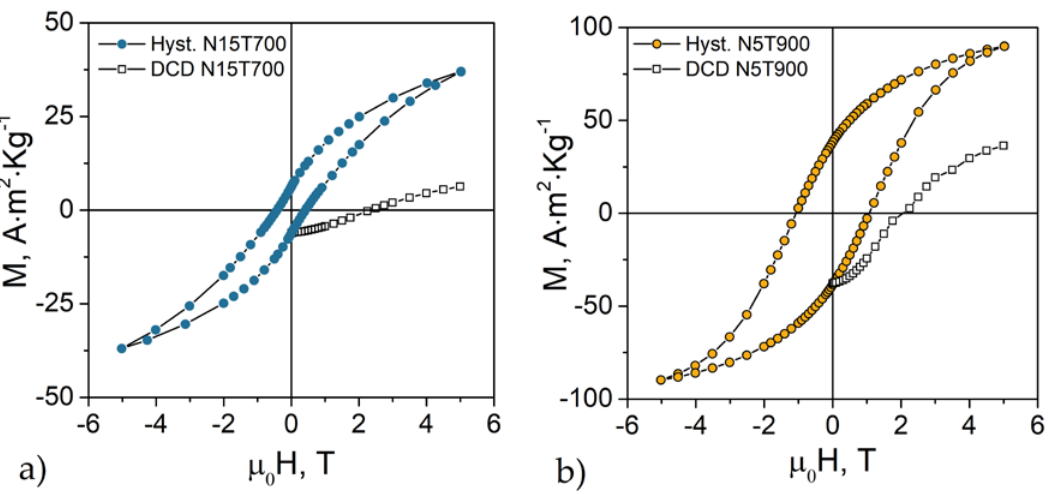
Figure 3. Field-dependence of magnetization and direct current demagnetization (DCD) curves measured at 5 K for ( a ) sample N15T700 and ( b ) reference sample N5T900 with the same particle size [14].